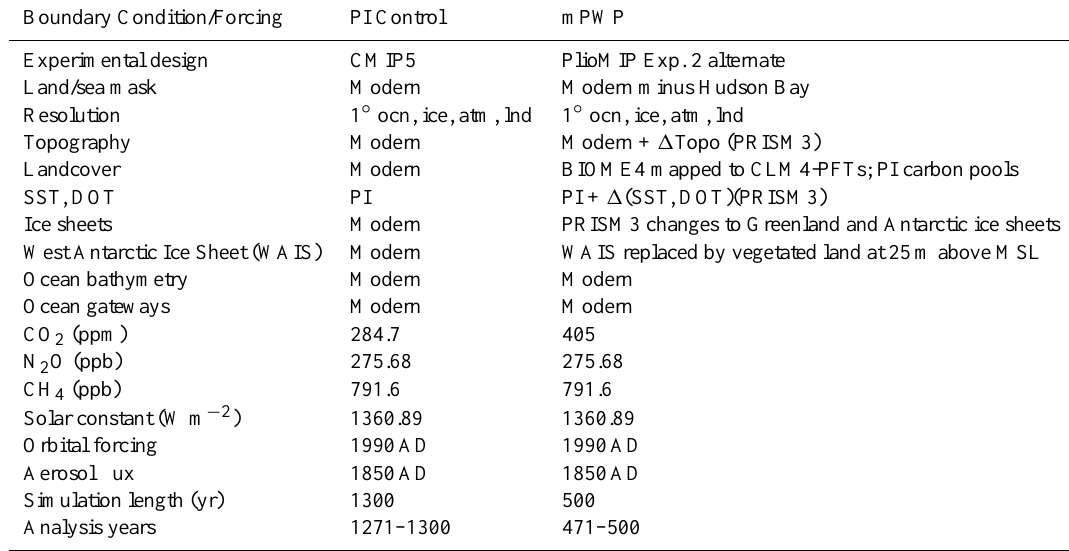
Table 1. Summary of forcings and boundary conditions for the mPWP and 1850 PI control simulations. Boundary Condition/Forcing PI Control mPWP PlioMIP Exp. 2